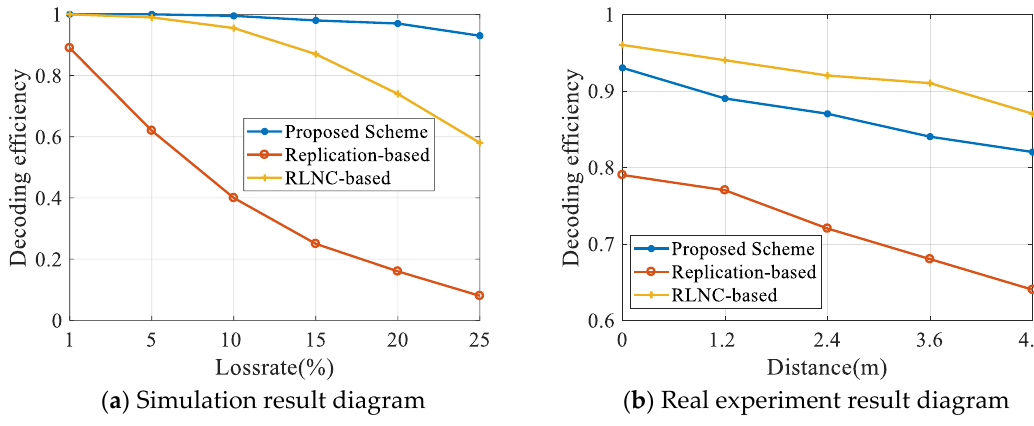
Figure 6. Influence of loss rate and distance on SDR.